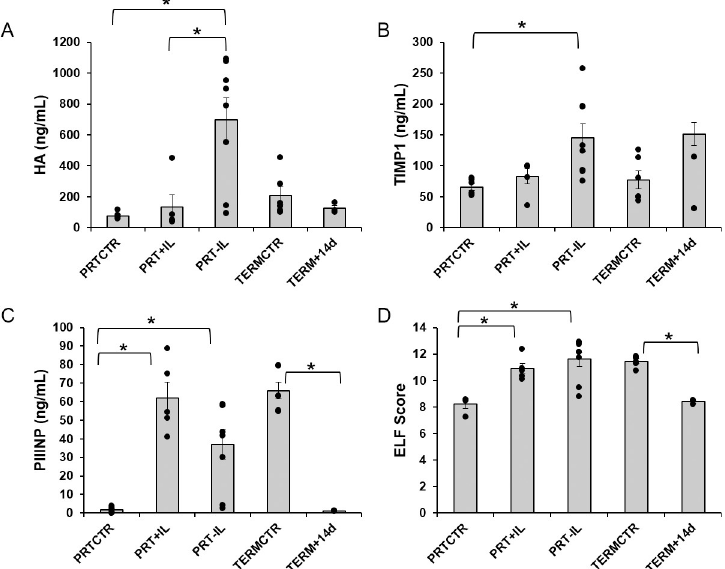
Fig 2. Serum markers of liver fibrosis in infant baboons. Mean [A] Hyaluronic Acid (HA, in ng/mL), [B] TIMP metallopeptidase inhibitor 1 (TIMP1, in ng/mL), and [C] Amino-terminal Propeptide of Type-III Collagen (PIIINP, in ng/mL) levels are shown for each group. [D] Mean Enhanced Liver Fibrosis score (ELF Score) is shown for each group. Error bars represent ± SD. � , P < 0.05, significance is based on one-way ANOVA with Bonferroni Post-Hoc. PRTCTR: preterm gestational control, n = 6; PRT+IL: preterm with Intralipids, n = 5; PRT-IL: preterm without Intralipids, n = 8; TERMCTR: term gestational control, n = 6; TERM+14d: term gestational control surviving 14 days, n = 3. https://doi.org/10.1371/journal.pone.0228985.g002 greatest area (0.43), followed by ALT (0.37), GGT (0.36), HA (0.35), and ELF score (0.30); direct bilirubin (0.29) and AST (0.18) had the lowest AUCs. TIMP1 also had the greatest ability to discriminate microvesicular steatosis among the serum biomarkers (AUC: 0.48). The Spear- man’s correlation coefficients between TIMP1 and markers of liver disease were low and non- significant (fibrosis: r = 0.14, p = 0.40; microvesicular steatosis: r = 0.14, p = 0.43; and Kupffer s s cell hypertrophy: r = 0.18, p = 0.29). The Spearman’s correlation coefficients between HA and s markers of liver disease were somewhat higher, but remained nonsignificant (fibrosis: r = s 0.25, p = 0.14; microvesicular steatosis: r = 0.28, p = 0.1; and Kupffer cell hypertrophy: r = s s 0.45, p = 0.07). Finally, Spearman’s correlation coefficient between ELF score and makers of